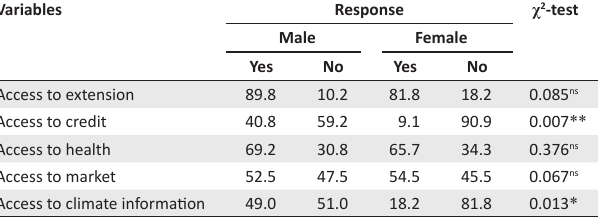
TABLE 1: Household’s access to public service by gender ( % ) and chi-square tests to test the relationship between gender and public services.